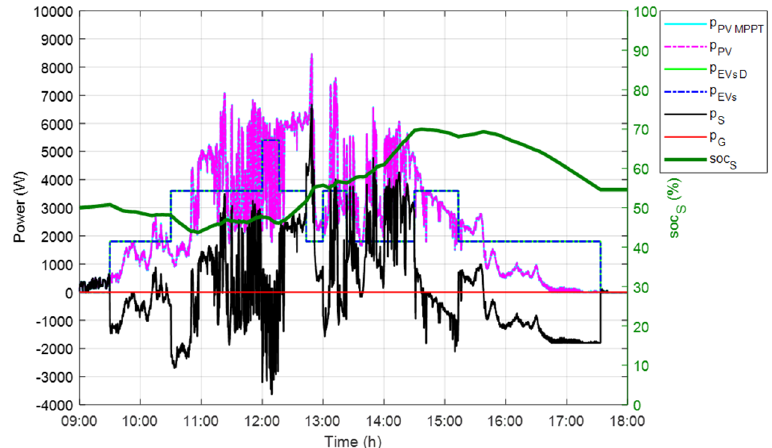
Figure 15. Scenario 2a, system power flows and stationary storage SOC evolution.